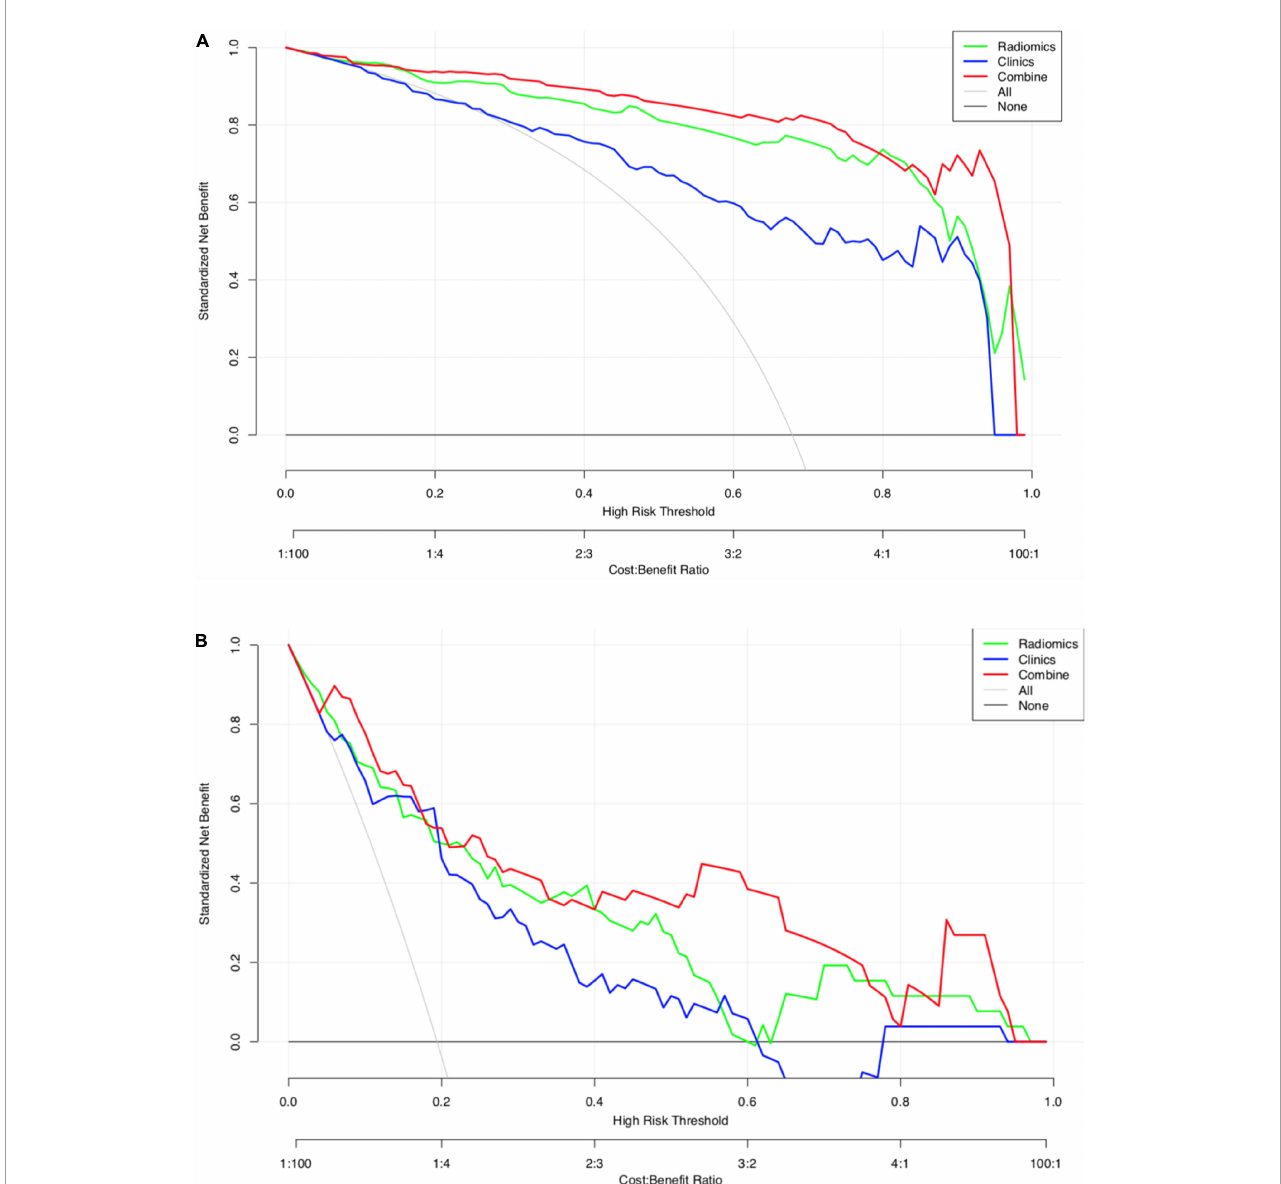
FIGURE4 (A) Decision curve analysis for the three models (HIE vs. normal). The green line and red line represent the radiomics model and combined nomogram model. The blue line represents the clinical model. Decision curves showed that combined nomogram model achieved more clinical utility than radiomics model and clinical model. (B) Decision curve analysis for the three models (good outcome vs. poor outcome). The green line and red line represent the radiomics model and combined